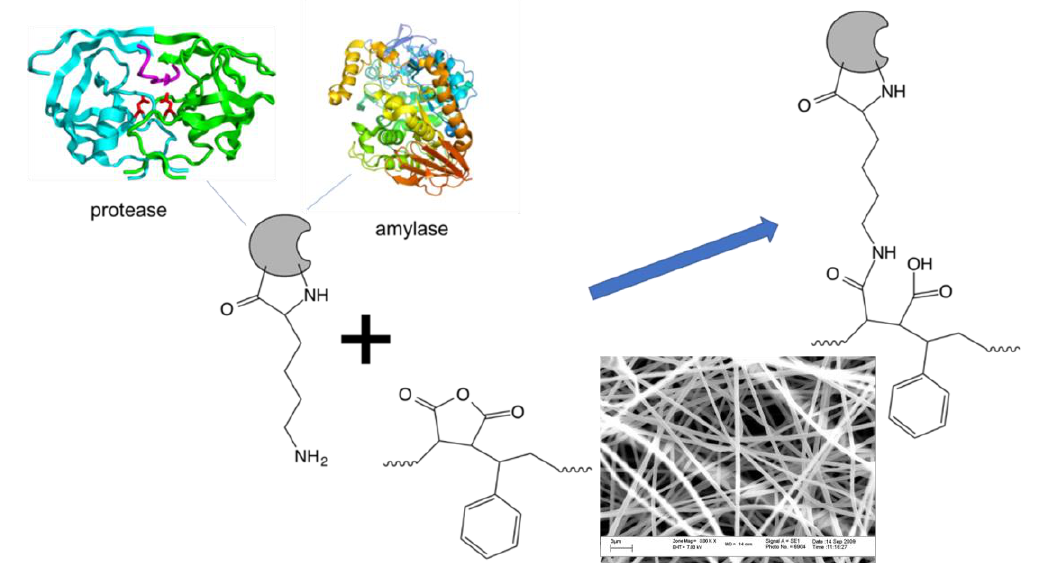
Figure 1. General scheme for immobilization of enzymes on poly(styrene- alt -maleic anhydride)